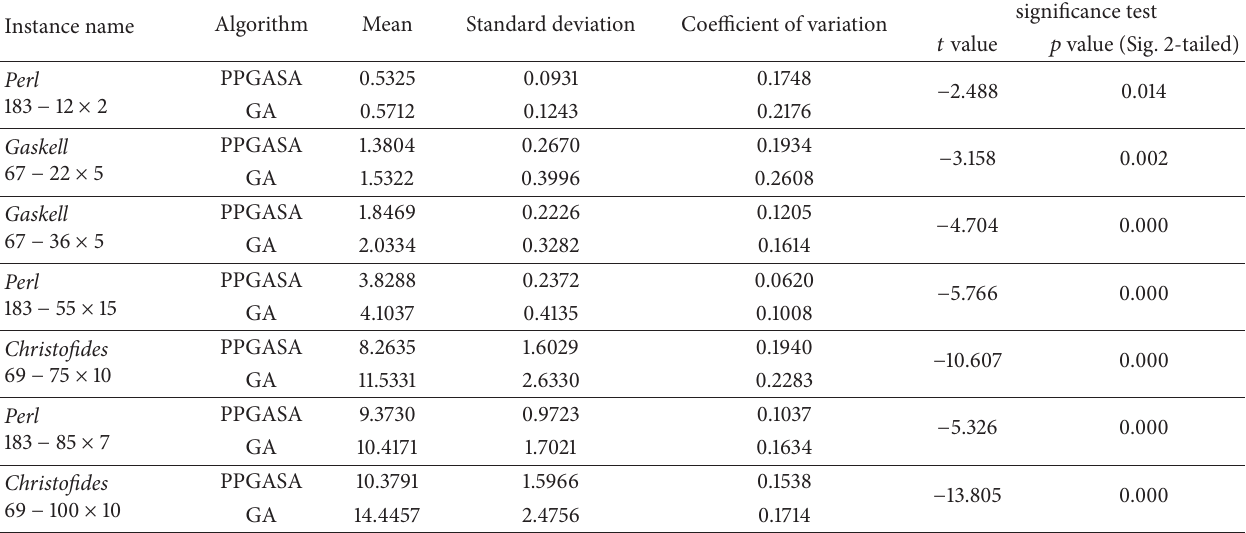
Table 9: CPU time of two algorithms